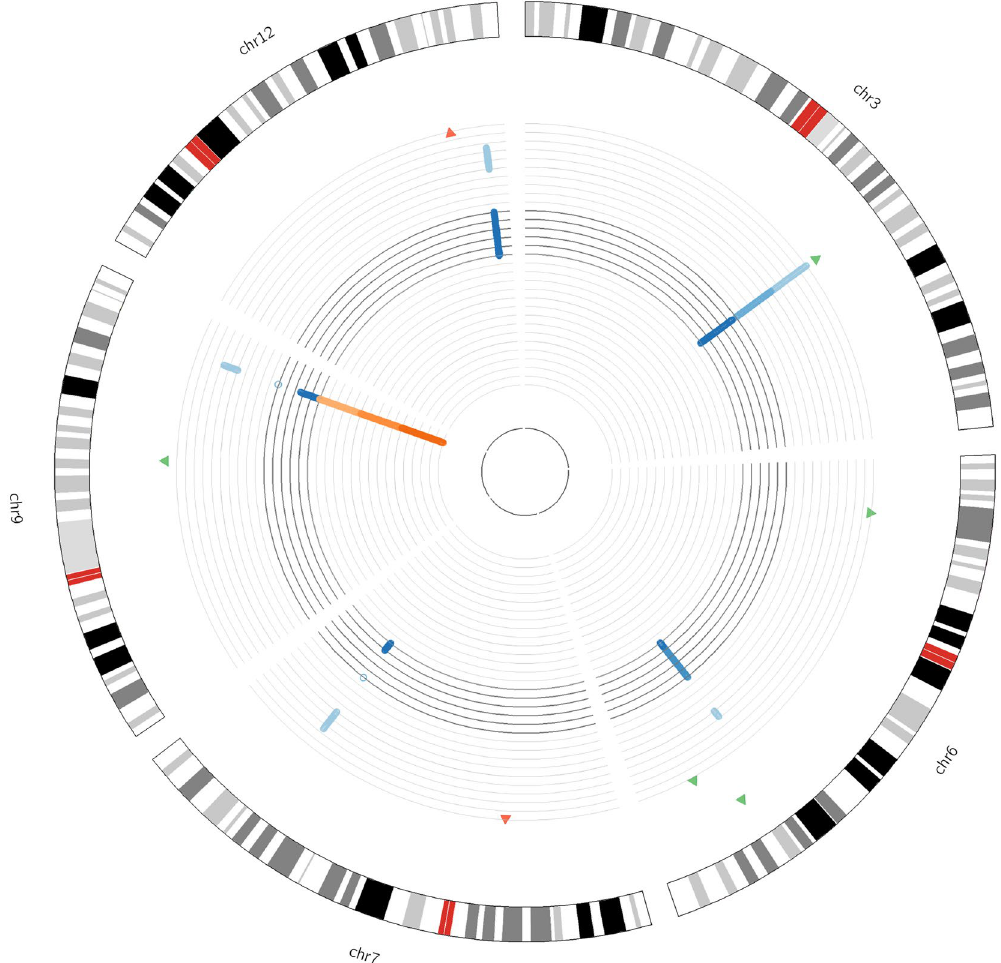
Figure 7. Circos plot of seven functional SNPs at moderate stringency. Circular representation of the location and p -value of the seven SNPs. The outermost ring represents autosome ideograms (chromosomal number is annotated), with the pter-qter orientation in a clockwise direction. The second outermost circle represents T2DM-associated SNPs and the p -value from GWAS. The four blue circles represent the read coverage from ChIP-seq data of four different tissues (light blue for adipose, blue for liver, dark blue for liver, very dark blue for pancreas). The four innermost, orange rings represent the read coverage from RNAseq of four different tissues (light orange for adipose, orange for liver, dark orange for liver, very dark orange for